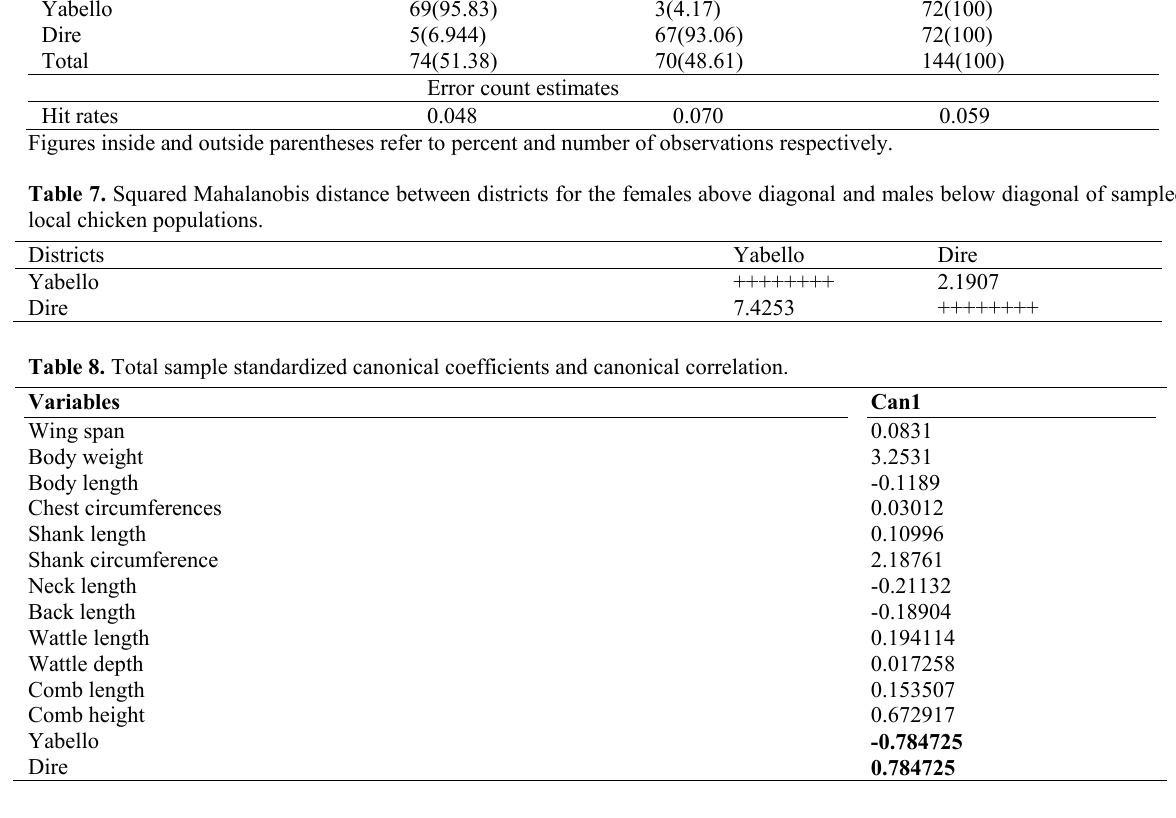
Hit rates Figures inside parentheses refer to percent of observations and figures outside parentheses refer to the number of observations. Table 2. Classification of male chicken sampled population from the two sites by discriminant analysis. District Yabello Dire Overall Yabello